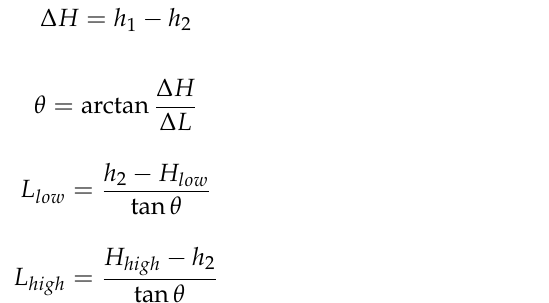
Figure 4. Schematic diagram of tidal-level correction principle.